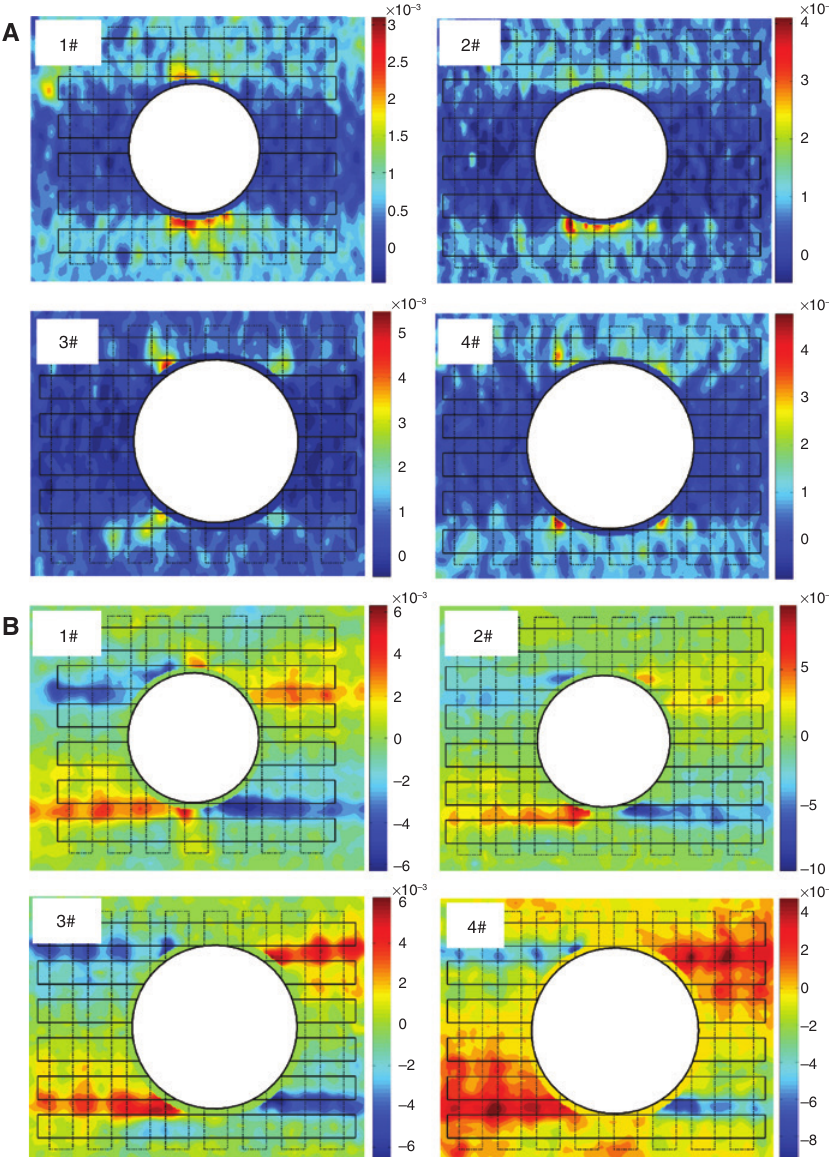
. (B) Shear strain distribution γ 11